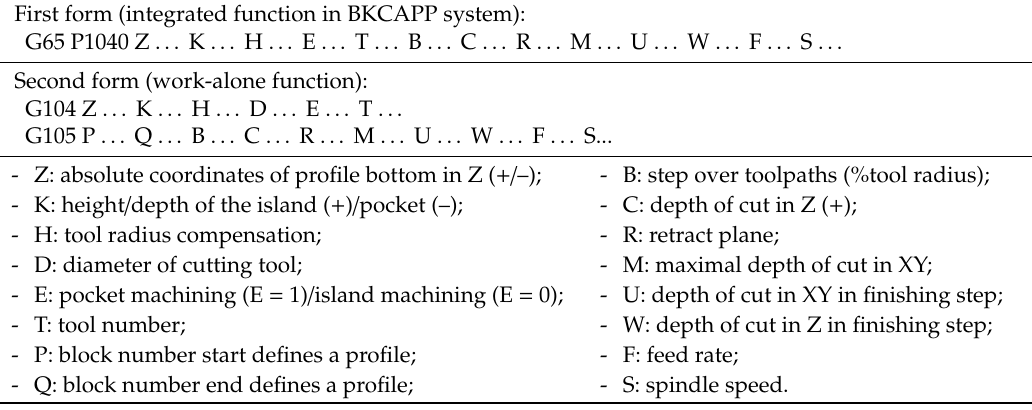
Table 3. Two G-code forms for contour features.